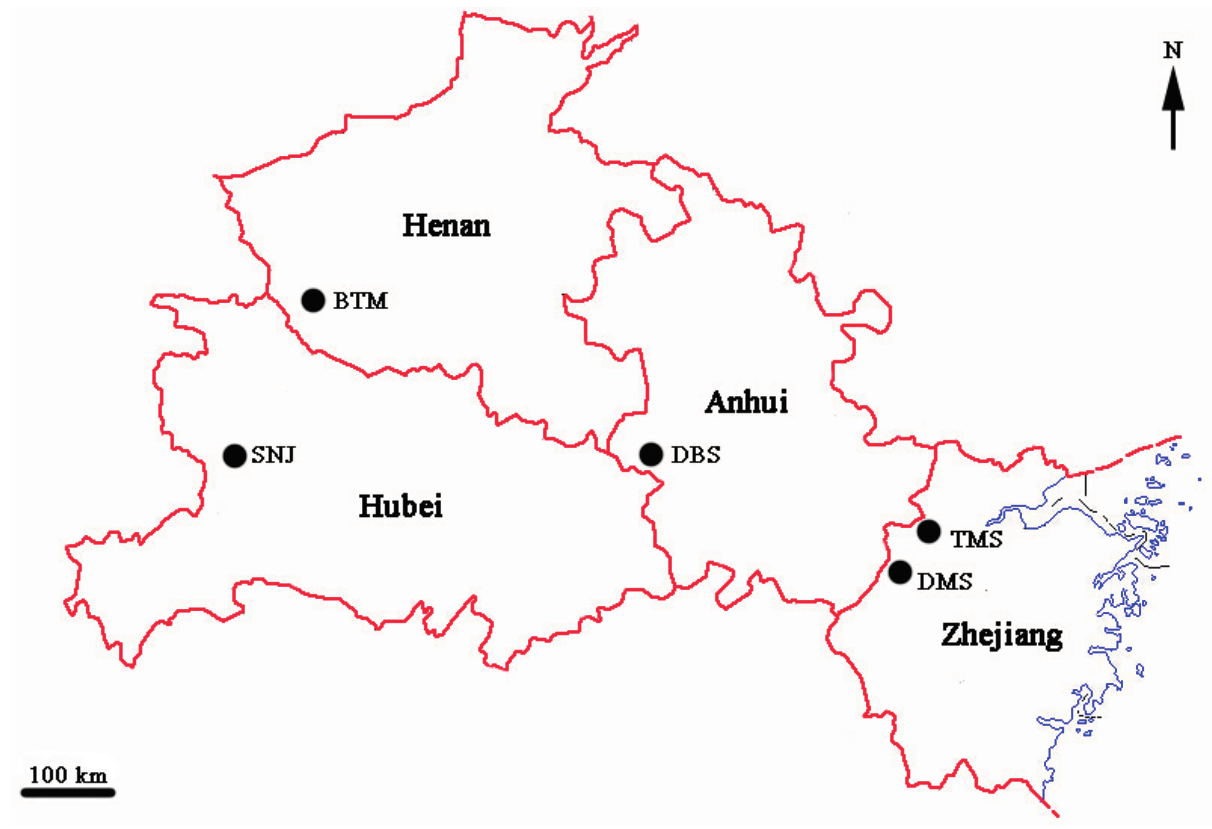
Figure 7. Map of five sampled populations of C. japonicum in China.